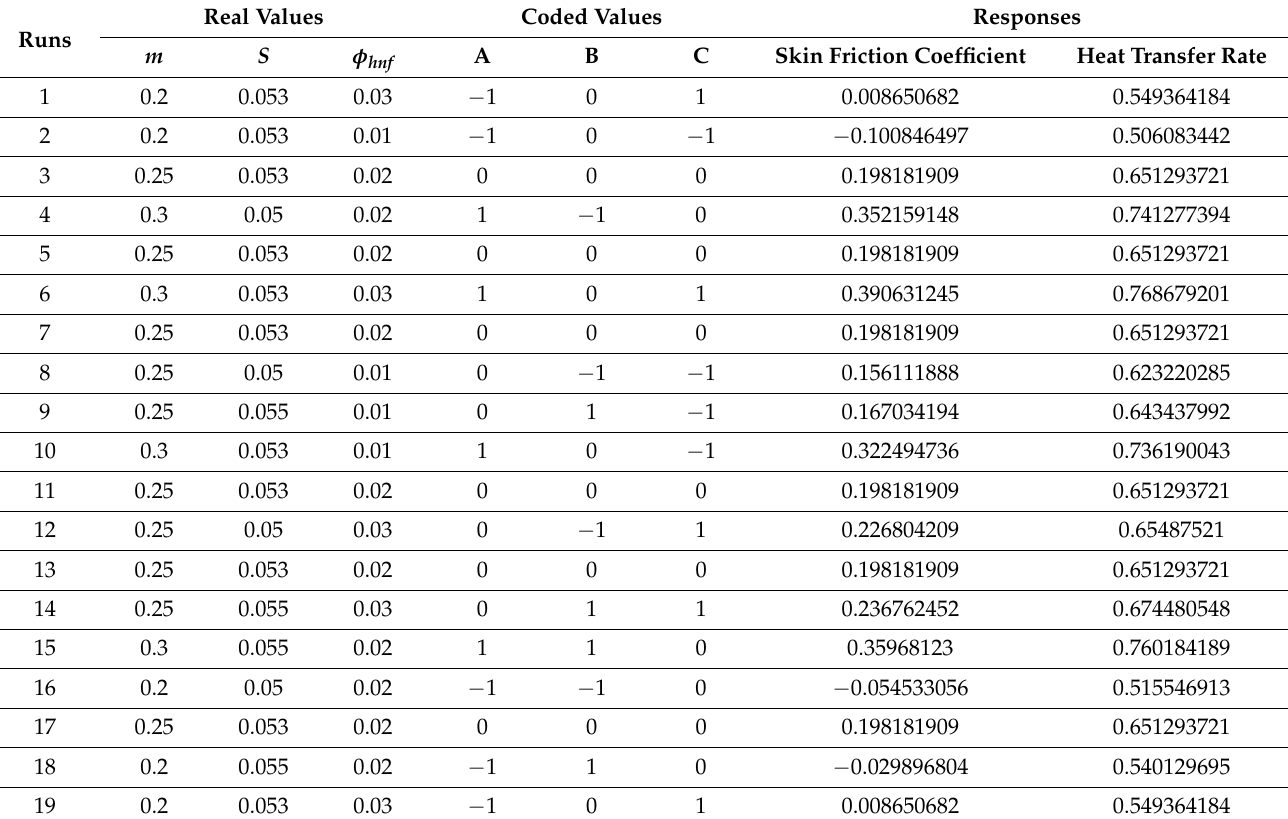
Table 6. Response surface methodology with central composite design for the factors and